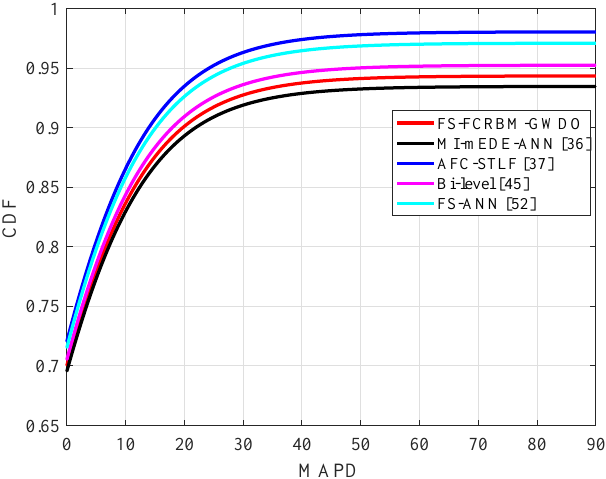
Figure 14. Evaluation of CDF in terms of MAPD for the proposed FS-FCRBM-GWDO model and benchmark models on FE power grid hourly load